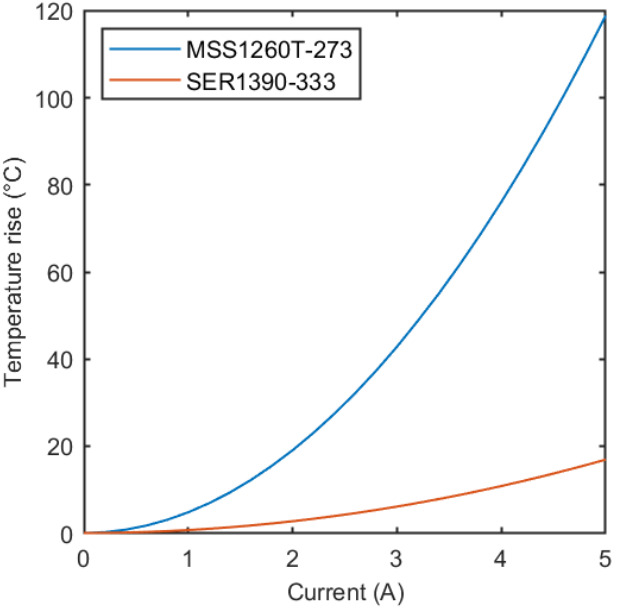
Figure 6. Temperature rise vs. output current for the two tested inductors [16,17].